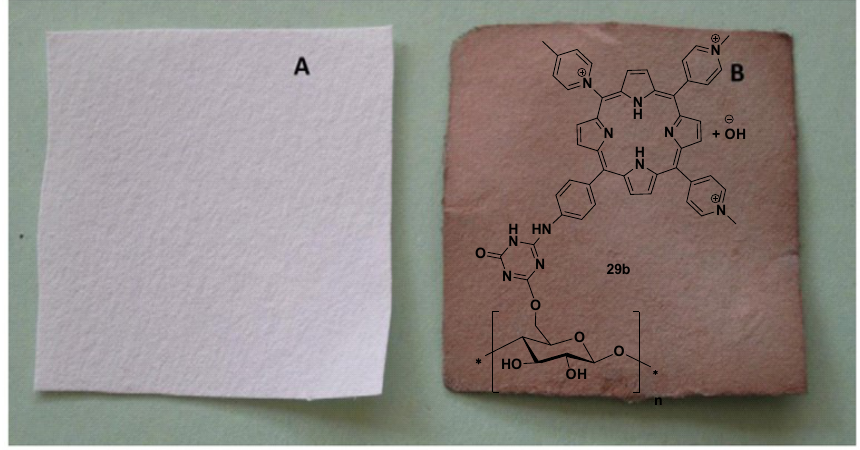
Figure 21. Photographs of ( A ) filter paper; ( B ) filter paper after reaction with 28b giving 29b . Reprinted with permission from Ref. [167]. 2012, Elsevier.